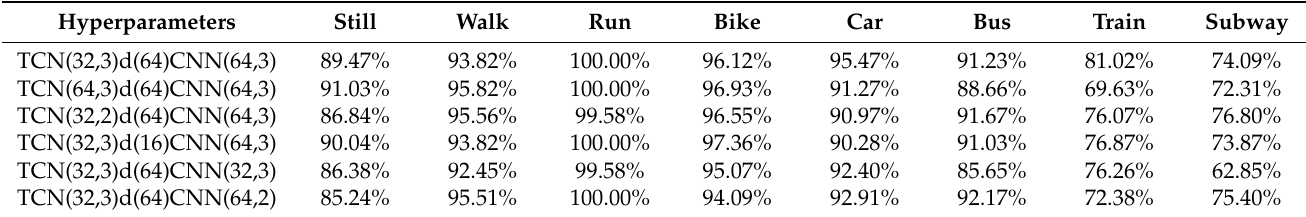
Table 8. Comparison of the precision of different hyperparameters on the SHL dataset. Hyperparameters